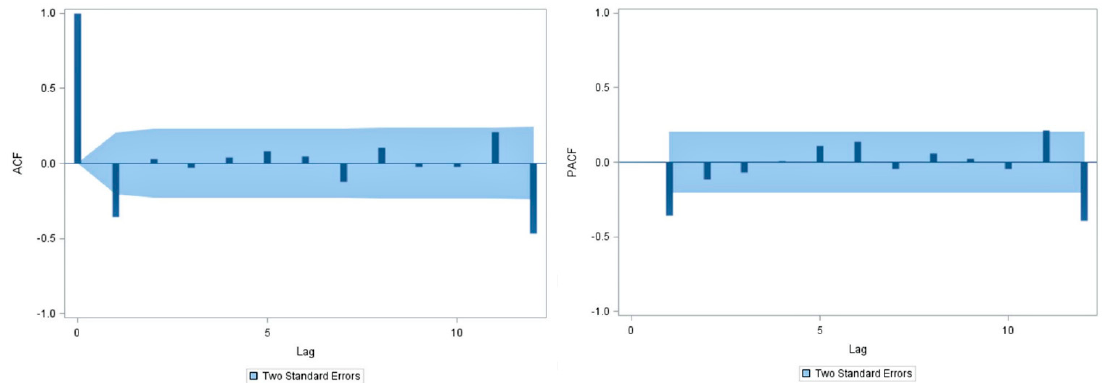
Figure 6. Autocorrelation function (ACF) and partial autocorrelation function (PACF) figures after the logarithmic transformation and difference (the shaded portion is the 95% confidence interval (CI) range).